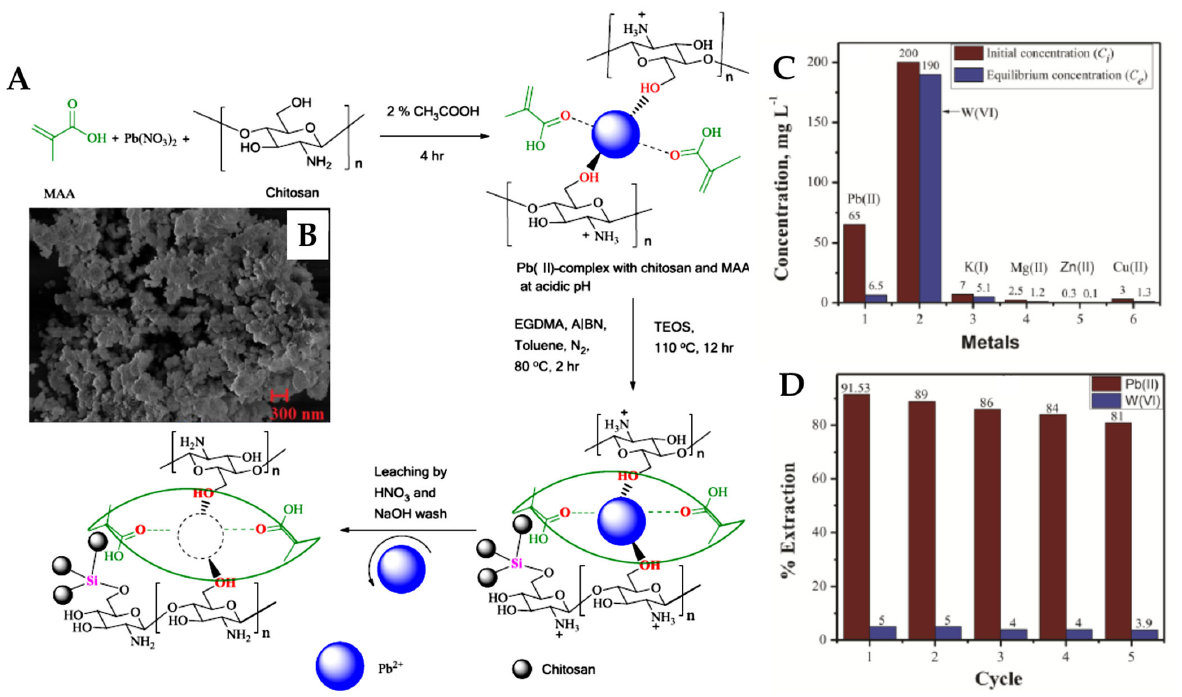
Figure 20. ( A ) Preparation of P(MAA ‐ EGDMA) ‐ g ‐ CS IPN hydrogels in presence of Pb(II) ions as template. ( B ) SEM micrograph of the Pb(II) ‐ imprinted P(MAA ‐ EGDMA) ‐ g ‐ CS IPN hydrogels. Sorption of Pb(II) ions in presence of competitive HMIs from printed circuit board recycling unit wastewaters ( C ) and sorption of Pb(II) and W(VI) in five consecutive cycles ( D ) in column setup (pH 6, flow rate 2 mL/min, column: height 7 cm, diameter 8 mm). (Adapted with permission from Ref. [207]. Copyright 2016 American Chemical